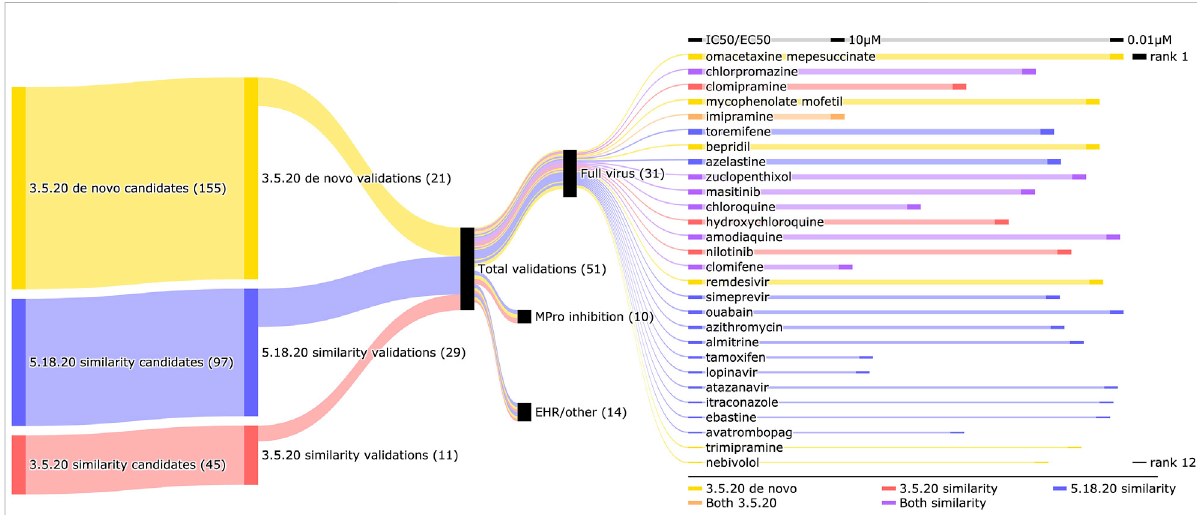
FIGURE 3 ValidationofSARS-CoV-2 fullvirusinhibitioncandidatesgenerated bytheCANDO platform. The fl owofvalidationsamongthethreecandidate lists generated using the CANDO platform are depicted from left to right using a Sankey diagram. The 155 candidates from 3.5.20 de novo (yellow) yielded21 validations, while thesimilaritycounterpartfrom thesamedate (red)produced11validationsfrom 45candidates.The5.18.20similaritylist (blue)of97approveddrugsresultedin29validations,resemblingthehitrateof3.5.20similaritylistandmorethantwicethatofthelone denovo list. The 51 total validations were comprised of 31 full virus studies, 10 main protease (Mpro) inhibition studies, and 14 EHR or other inhibition based studies. The compounds that were validated via afull virus inhibition of less than 10 μ M are shown prioritized by their rank in the list (or best rank if in multiple lists) corresponding to the thickness of their bars (ranging from rank 1 – 122). All but six drugs were in a single list, fi ve drugs were in both similaritybasedlists(purple)andonewasinboththe3.5.20similarityand denovo lists(orange).Thelengthofthehorizontalbarnexttothenamesof thecompoundsindicatesthelowestreportedEC50orIC50frompublishedexperimentalstudiesprogressingonalinearscale.Thesecondstrongest reportedEC50(0.03 μ M)belongstoomacetaxinemepesuccinate,whichisthetopcandidatefrom3.5.20 denovo .Thecorrelationbetweenrankand strength of inhibition is sub-moderate (0.3718), and this is possibly due to the variation in assay design among different studies (viral replication reduction, viral entry inhibition, viral induced cytopathic effect reduction, etc). Overall, the CANDO platform was able to identify several candidates with potent anti-SARS-CoV-2 activity using two different predictive pipelines, verifying its potential to rapidly and ef fi ciently respond to emerging threats to global